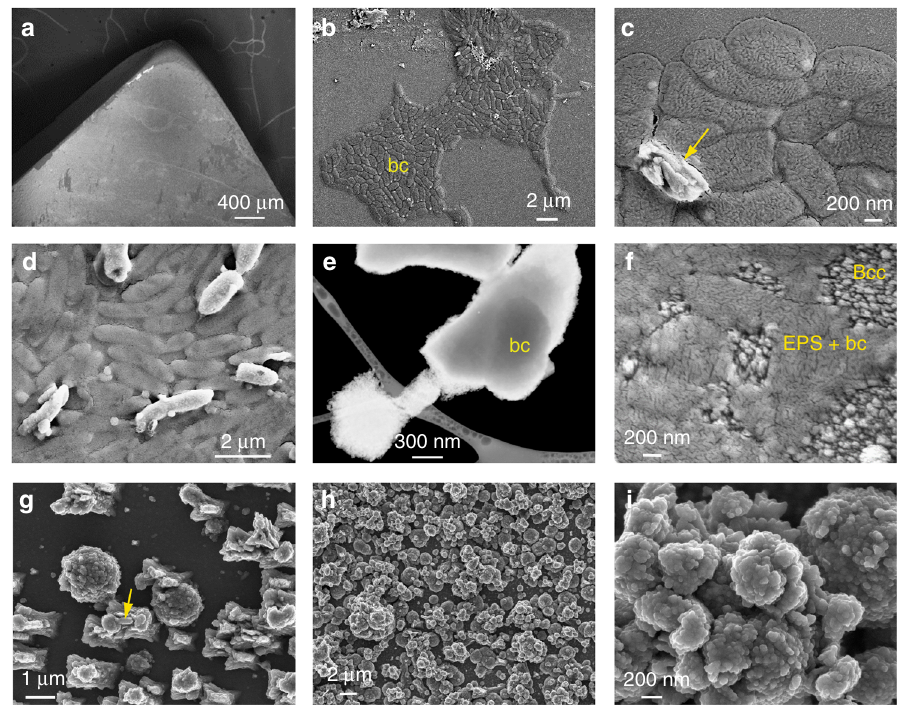
Fig. 4 SEM photomicrographs of bacterial attachment and CaCO 3 biomineralization on calcite. a General overview of the calcite substrate subjected to bacterial biomineralization; b bacterial cells (bc) onto calcite 17 h after inoculation; c detail of bacterial cells and newly formed CaCO 3 ( arrow) ; d initial calci fi cation of bacterial cells that keep their rod-shaped morphology, whereas uncalci fi ed cells ( darker contrast ) collapse during sample preparation (drying) and observation (high vacuum); e bright fi eld (negative) SEM image taken with an STEM detector of bacterial calcite crystals formed after 24 h incubation time, one of them including an entombed bacterial cell (bc); f bacterially induced CaCO 3 crystals (Bcc) along with EPS and collapsed bacterial cells (EPS + bc) on the calcite substrate; g bacterial calcite structures formed on the calcite substrate during the early stages of biomineralization (24 h after inoculation). Rod-like bacterial cells are seen partially entombed in newly formed CaCO 3 ( arrow ); h calcite substrate fully covered by bacterial calcite after 48 h; i detail of the nanostructured bacterial calcium carbonate structures shown in